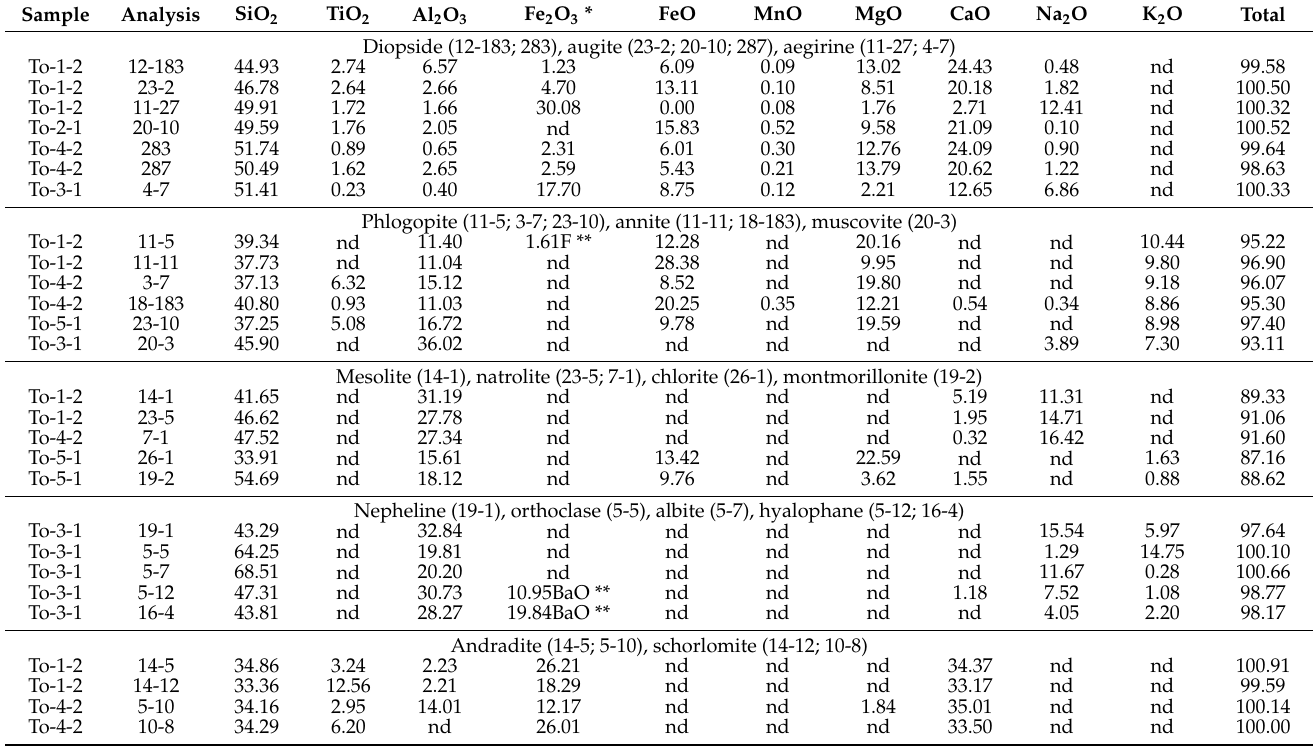
Table A2. Representative analyses of silicate minerals (all values in %; nd—not detected). Sample